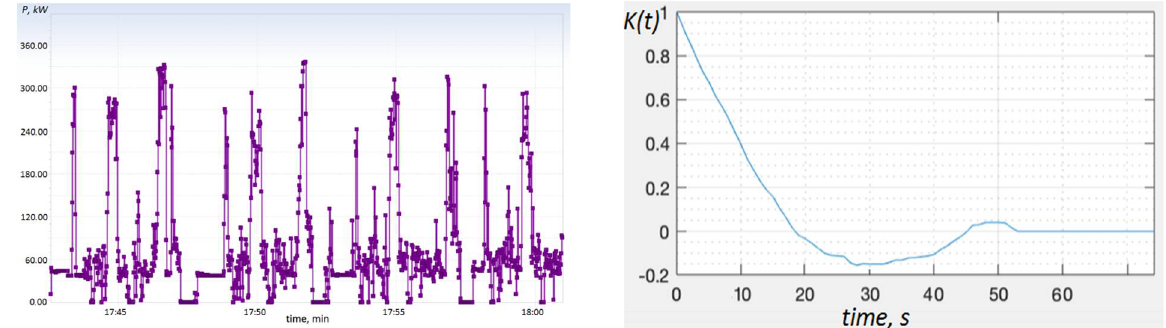
Figure 7. Fragment of the curve of active power consumption overhead crane with a VFD and his NCF.